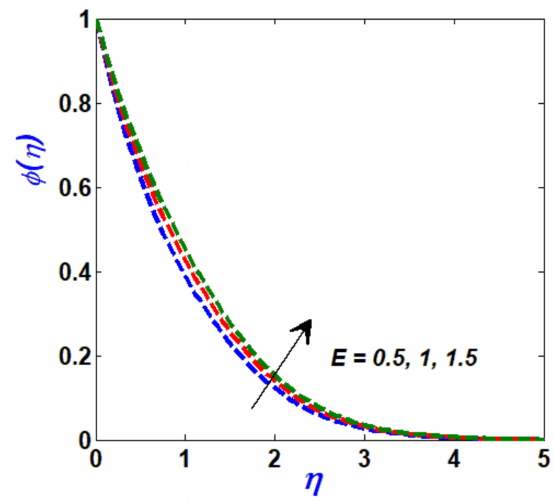
Figure 11. Concentration profile with variation in E .